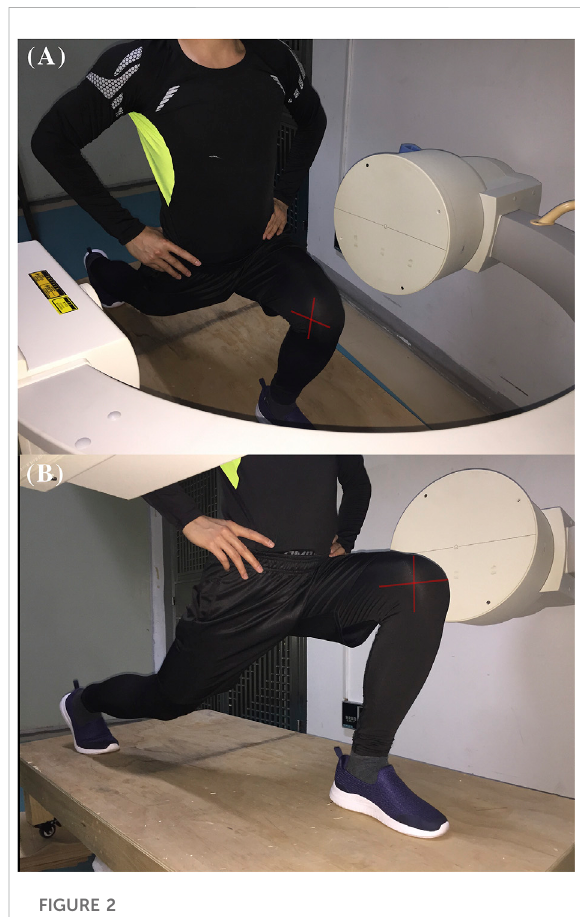
FIGURE 2 The single fl uoroscopic imaging system with a patient performing a single-leg